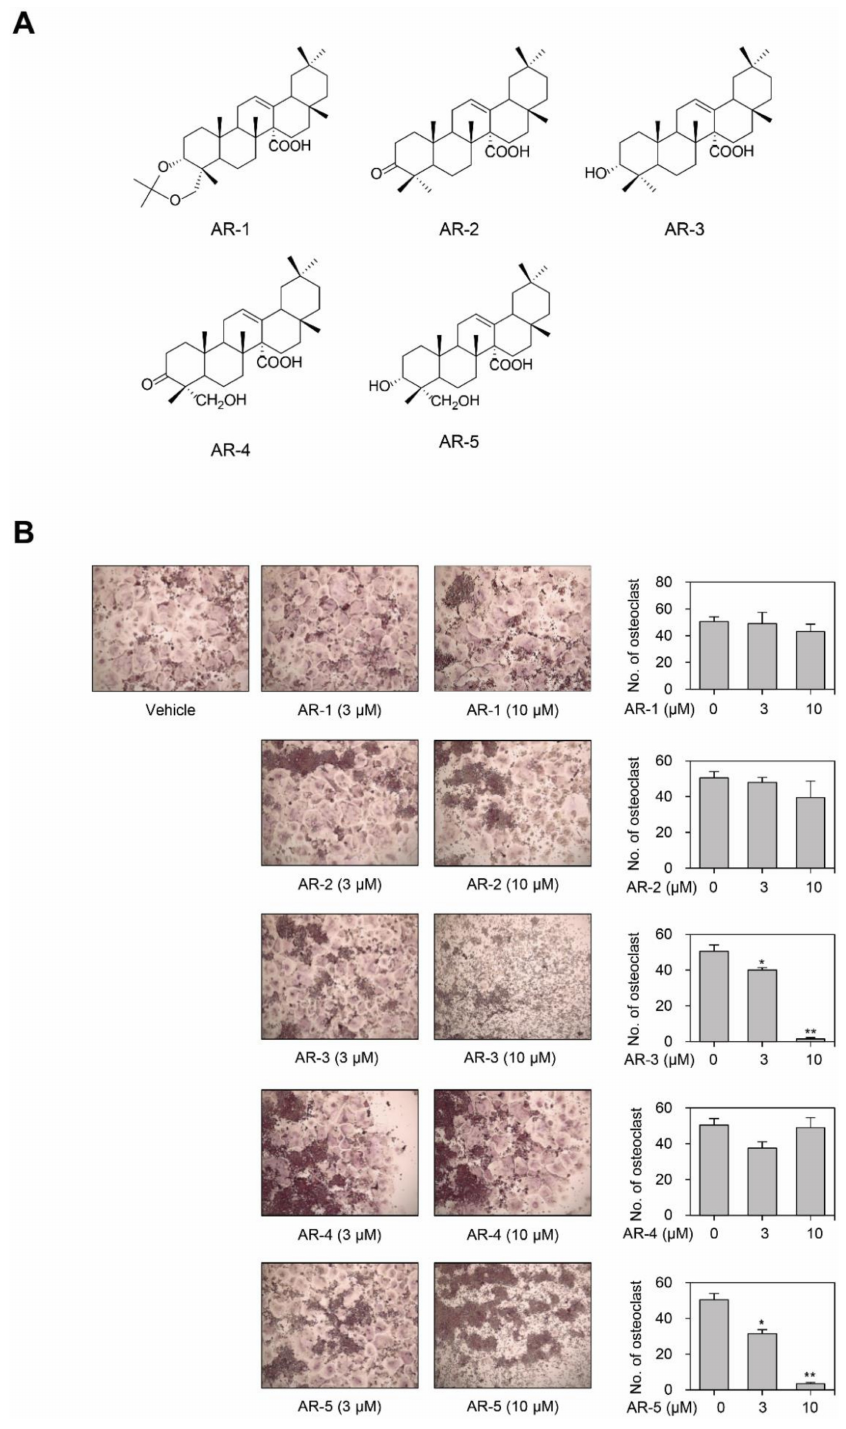
Figure 1. Olean-12-en-27-oic acid derivatives inhibit RANKL-induced osteoclastogenesis. ( A ) Chemical structures of olean-12-en-27-oic acid derivatives isolated from A. rossi . ( B ) E ff ect of olean-12-en-27-oic acid derivatives on RANKL-induced osteoclastogenesis. RAW264.7 cells were cultured into 96 well-plates under stimulation of RANKL with or without di ff erent concentrations of the indicated compound for four days, then the cells were stained for TRAP. The quantities of TRAP-positive multinucleated ( > 5 nuclei) osteoclasts were determined following image capture. Data are presented as the mean ± SE (* p < 0.05 and ** p < 0.01, versus vehicle-treated control; n =